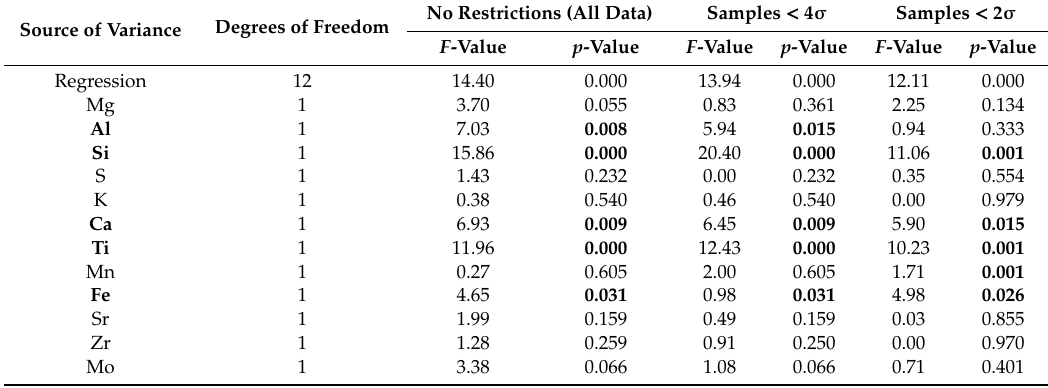
Table 4. All elemental data compared to porosity are compiled in increasing atomic number with various sample exclusions based on standard deviation of sample population. Values are listed in increasing atomic number. Elements with a significance greater than 95% ( p -value < 0.05) are